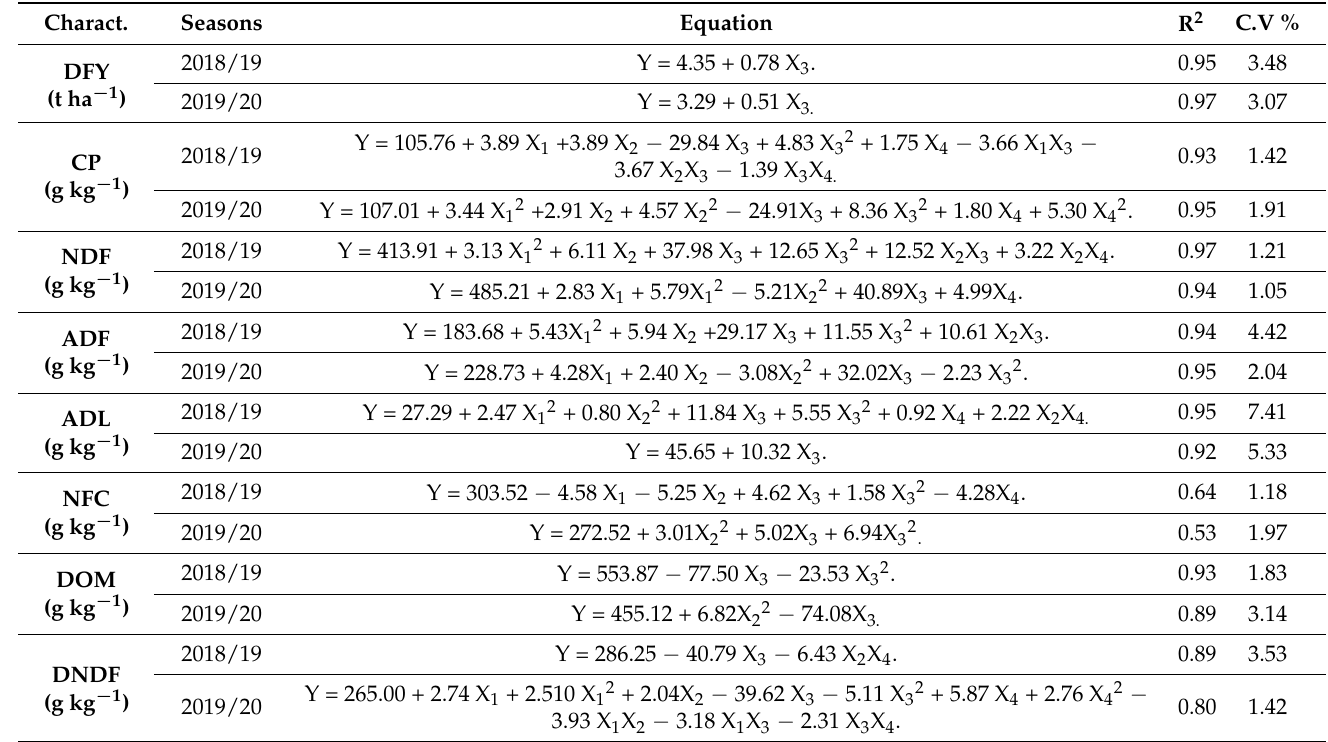
Table 4. Regression equations describing the relationship between dry forage yield (DFY), crude protein (CP), neutral detergent fiber (NDF), acid detergent fiber (ADF), acid detergent lignin (ADL), non-fiber carbohydrates (NFC) degraded organic matter (DOM), and degraded neutral detergent fiber (DNDF), and the investigated factors in 2018/19 and